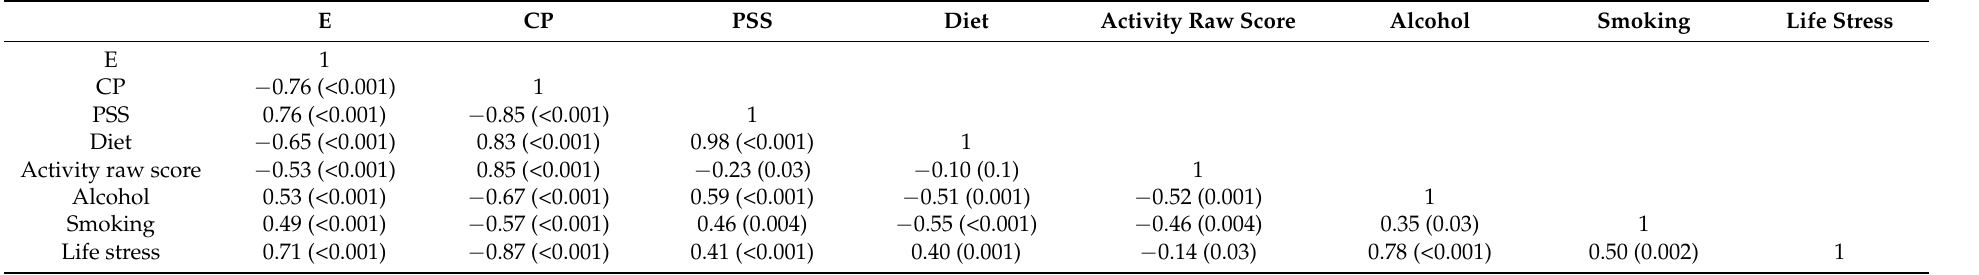
Table 3. Correlations between stress, cognitive performance, and lifestyle among participants during the